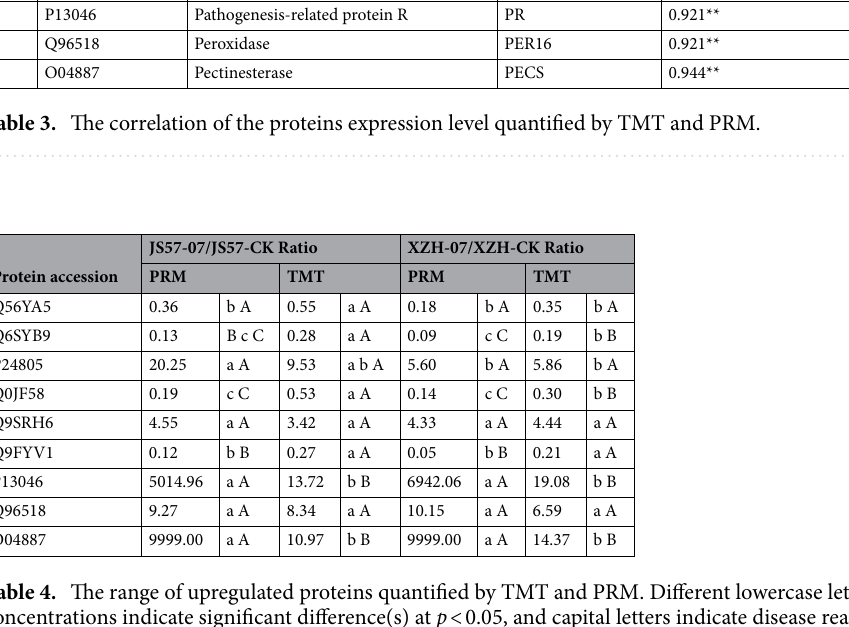
Table 4. The range of upregulated proteins quantified by TMT and PRM. Different lowercase letters among concentrations indicate significant difference(s) at p < 0.05, and capital letters indicate disease reaction.